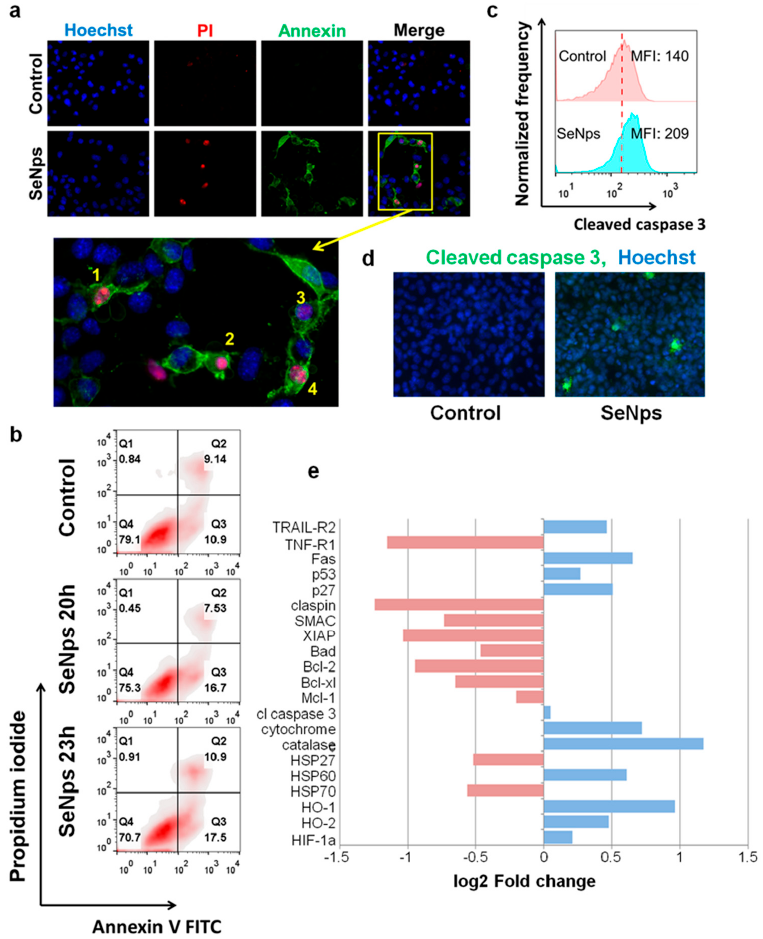
Figure 3. SeNps induce apoptosis in CT26 cells. ( a ) SeNps-induced morphological changes characteristic of apoptosis in CT26 cells. Cells were treated with 15 µ g/mL SeNps for 23 h and stained with Hoechst (blue), Annexin V-FITC (green) and PI (red) and were examined under a fluorescence microscope. Only SeNps-treated cells appear positive for either Annexin V or PI. Magnification of the inset from the Merge fluorescence image of SeNps-treated CT26 cells illuminate morphological changes that are typical in apoptotic cells: membrane blebbing (1–4), nuclear condensation (2), nuclear fragmentation (1, 4) and membrane protrusion formation (1, 4). Figure panel is adapted from [55] (magnification: 1200 × ). ( b ) Flow cytometry analysis of Annexin V/PI double staining of SeNps-treated CT26 cells. Density plots of control and treated cells. The percentages of viable (Annexin V-FITC and PI-negative), early apoptotic (Annexin V-positive and PI-negative), and late apoptotic/necrotic (Annexin V/PI-double-positive) cells are indicated on the plots. Cells were treated with 15 µ g/mL SeNps for 20 or 23 h and stained with Annexin V-FITC and PI before the analysis by flow cytometry. ( c ) SeNps induce activation of caspase 3 in CT26 cells. SeNps-treated CT26 cells (15 µ g/mL, 24 h) were fixed, permeabilised and labelled with an anti-cleaved caspase 3 antibody prior to the flow cytometry analysis. Fluorescence intensity histograms of control cells and cells treated with SeNps and median fluorescence intensities (MFIs). The activation of caspase 3 was detected by the shift in MFI in treated cells (MFI: 209) when compared to the controls, untreated cells (MFI: 140). ( d ) Caspase 3 activation was also detected by fluorescence microscopy. Images of control and SeNps-treated (15 mg/mL, 24 h) CT26 cells labelled with Hoechst (blue, nuclei) and a secondary Alexa Fluor 488-conjugated antibody (green) against anti-cleaved caspase 3 primary antibody (magnification: 400 × ). ( e ) Expression of apoptosis-related proteins in CT26 cells after SeNps treatment analysed with a mouse apoptosis array (ARY031, R&D). Fold change compared to control in the expression levels of selected proteins exhibiting down (red) or up-regulation (blue) upon treatment with